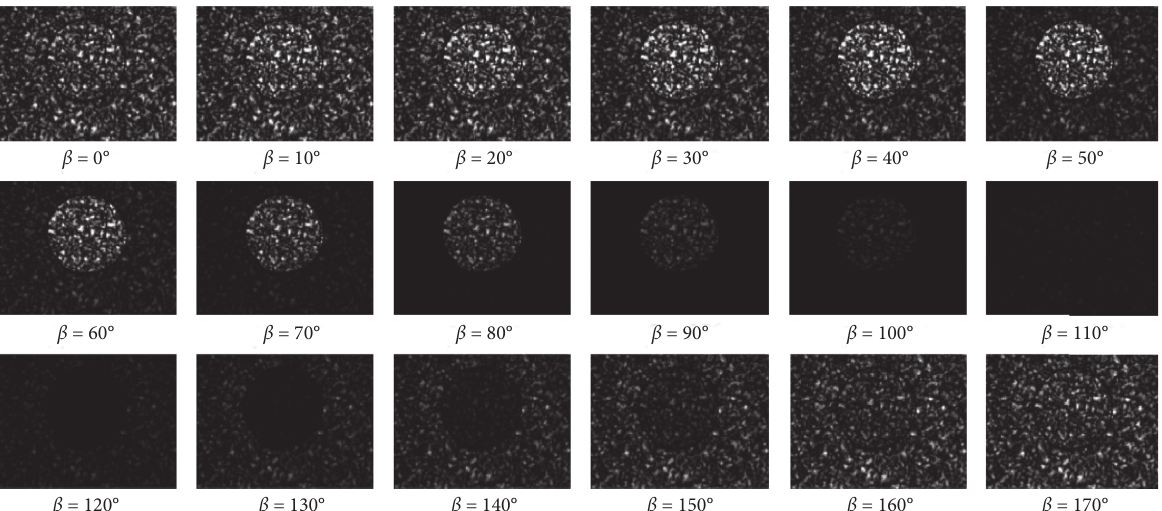
Figure 2: Set of speckle patterns obtained after three film polarizers.